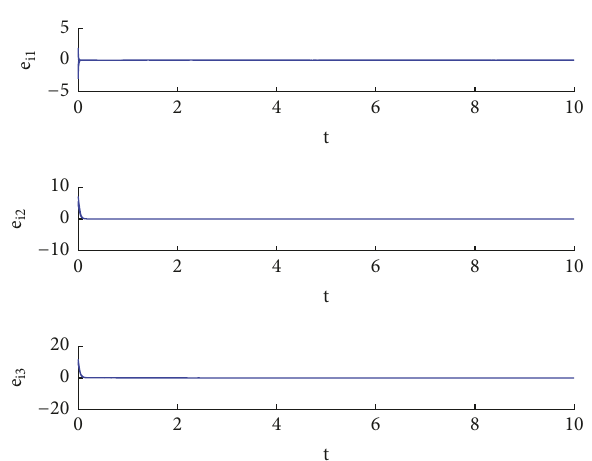
Figure 9: Mixed synchronization errors 𝑒 𝑖 (𝑖 = 1,2,...,10) with 𝐴 = 𝐵 .